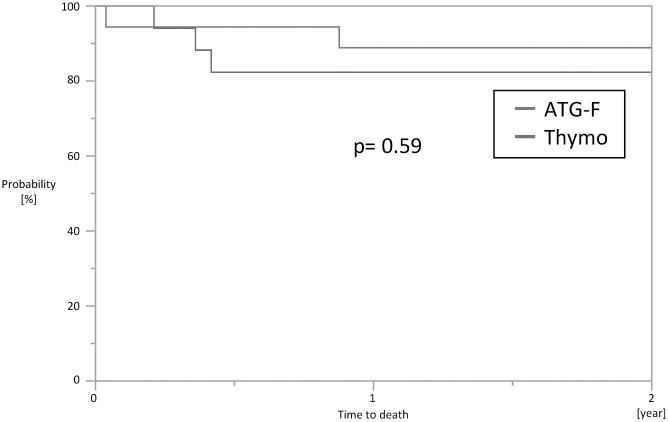
Patients survival.